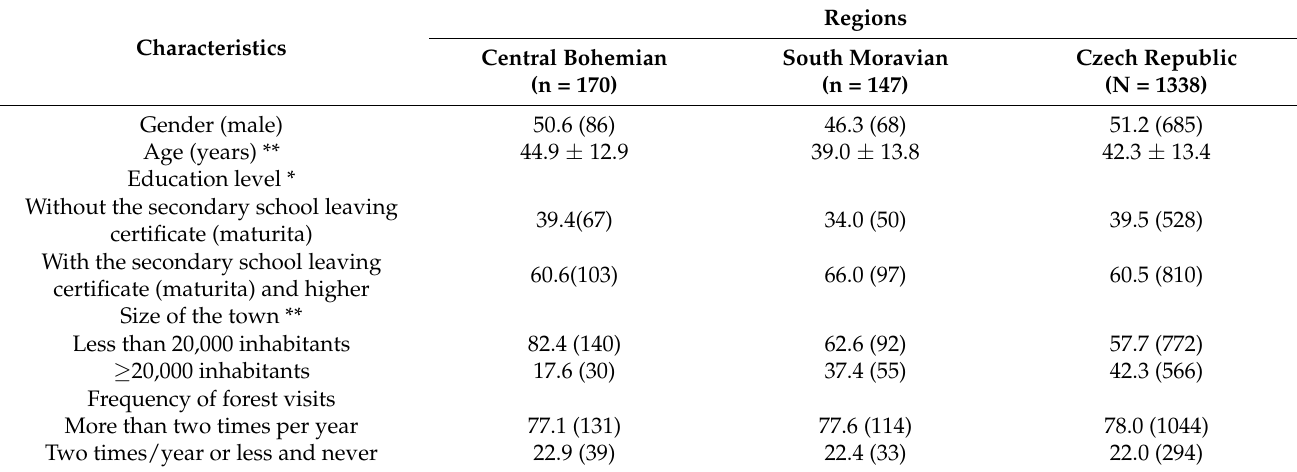
Table 4. General characteristics of the respondents 1.